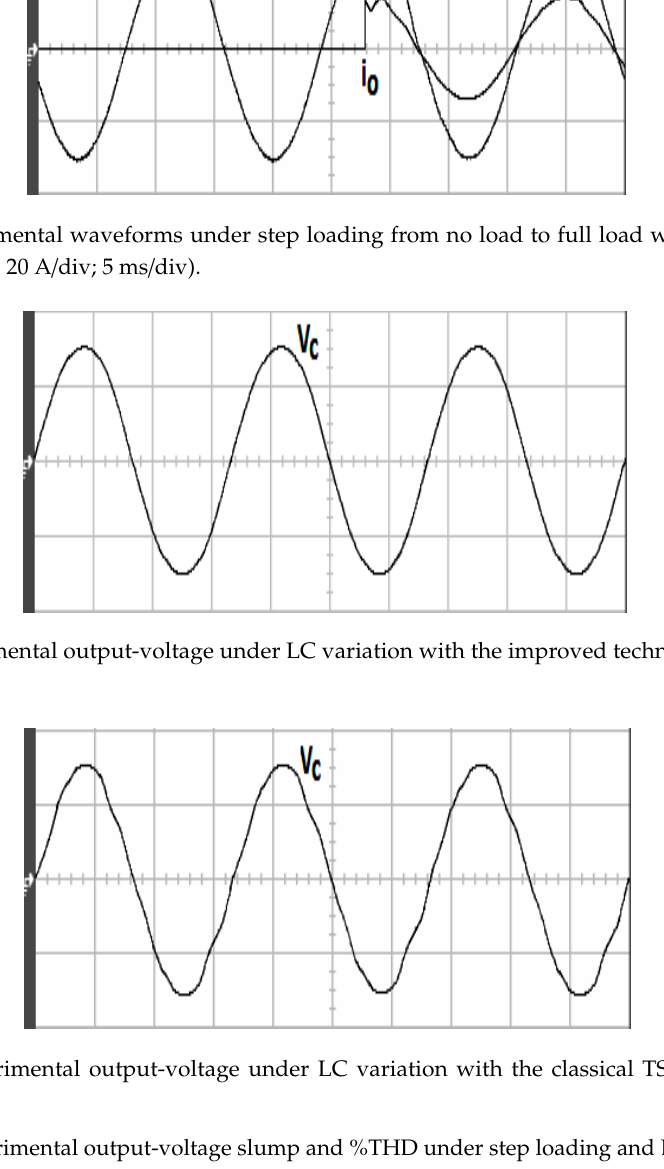
Table 2 . Experimental output-voltage slump and %THD under step loading and LC variation